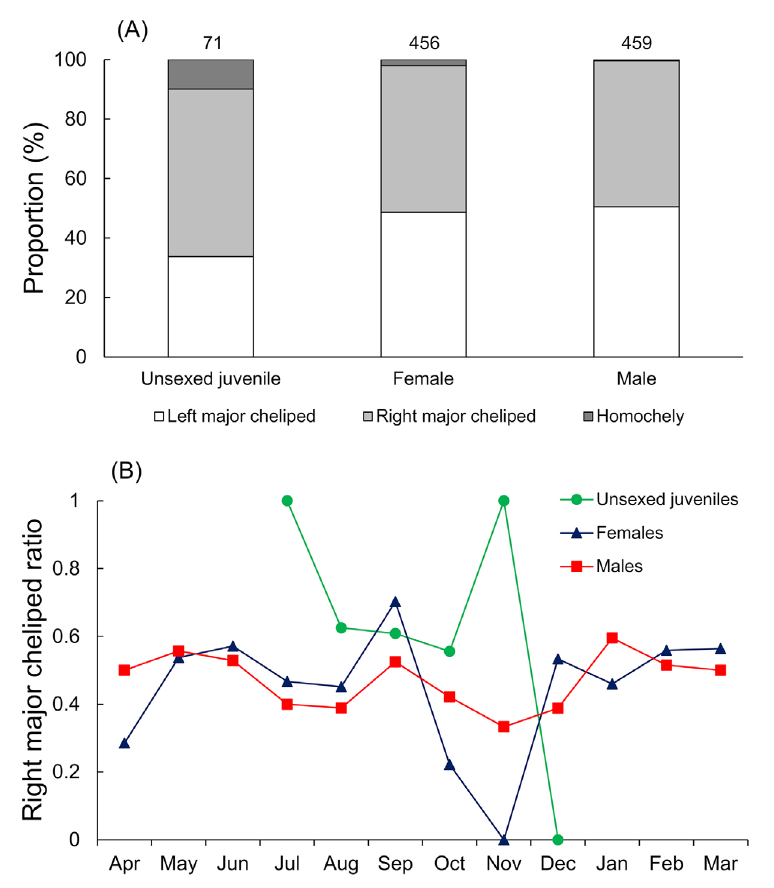
Figure 1. Overall proportions of specimens with either the left or right major chelipeds enlarged (heterochely) or identical-sized left and right chelipeds (homochely) (A) and monthly ratios of specimens with right major chelipeds (B) in unsexed juveniles, females and males of the porcellanid crab Petrolisthes japonicus . Numbers of specimens are shown above the